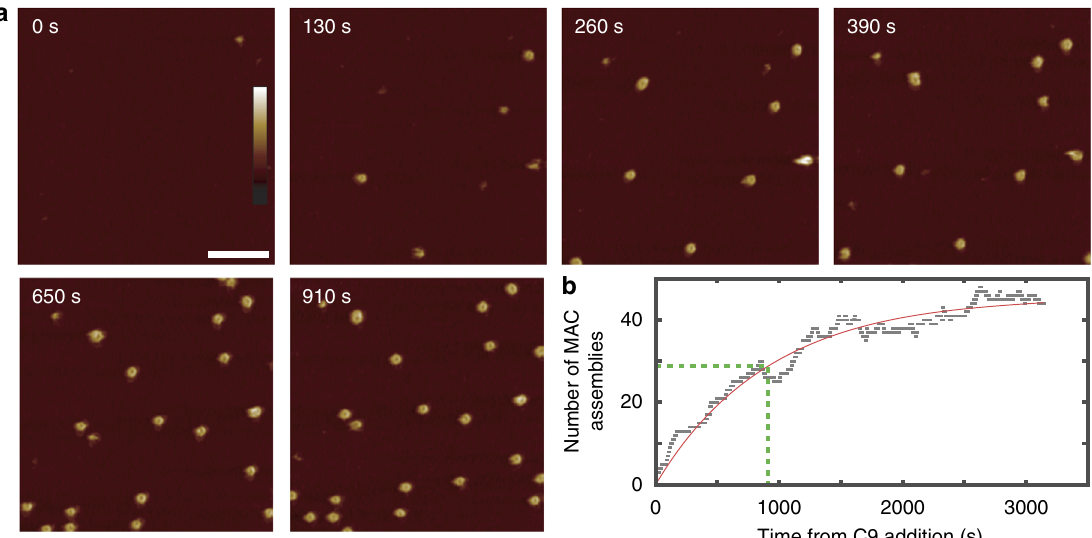
Fig. 3 AFM shows that initial insertion of C9 is rate limiting in MAC assembly. a Time-lapse AFM imaging of MAC assembly on supported bilayers formed of E. coli lipid extract (see Supplementary Movie 1 for full data set). MAC assembly events initiate at distinct time points, with each MAC pore rapidly completing within a few frames; this implies a rate-limiting-step corresponding to initial insertion of C9. Scale bar: 200 nm; height scale (colour scale bar inset in image for t = 0 min): 40 nm. b Number of MAC assemblies detected (see Methods) with time, indicated as grey squares; the solid red line represents fi tting with the function A (1 – exp( – t / τ init )), where τ init = 912 ± 32s represents the characteristic time of MAC pore appearance, highlighted by the dashed green lines. The completion time of each individual MAC is much shorter than τ